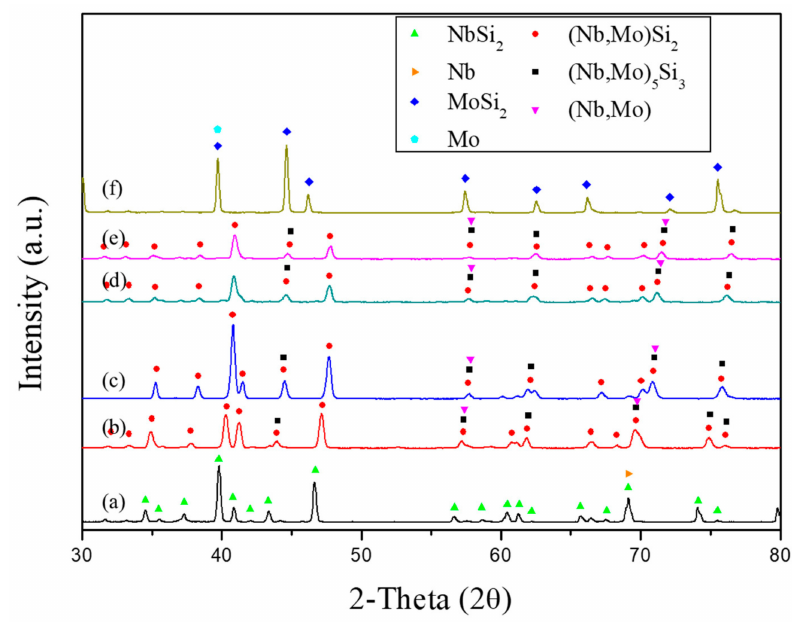
Figure 4. XRD patterns of Si-pack-coated specimens at 1100 ◦ C for 24 h with the compositions of